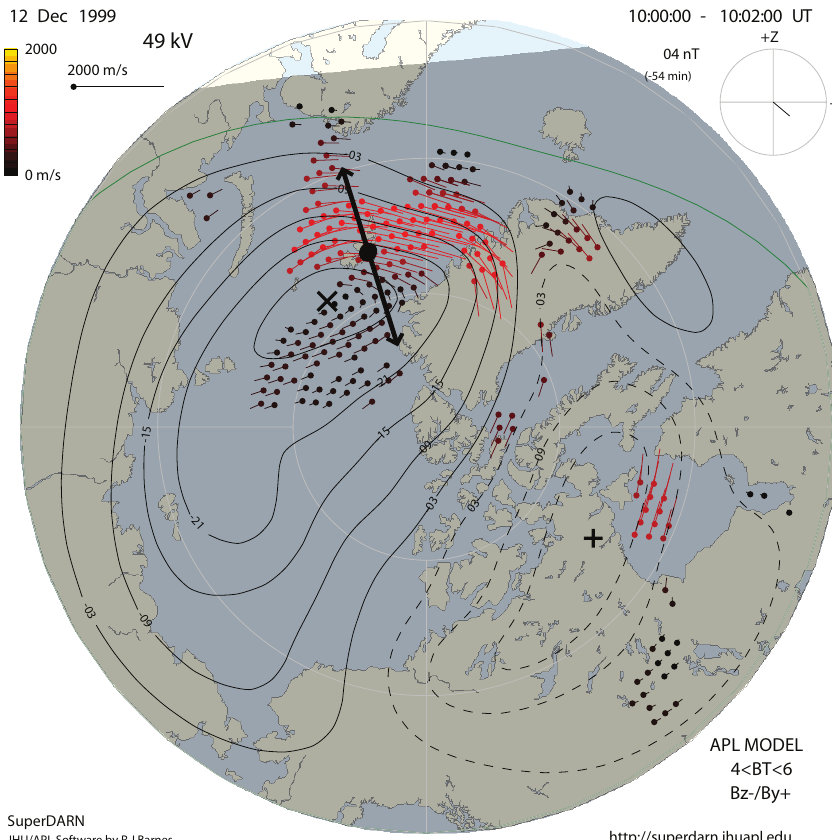
Fig. 16. SuperDARN plasma convection data for 10:00–10:02 UT. Same format as in Fig. 4.